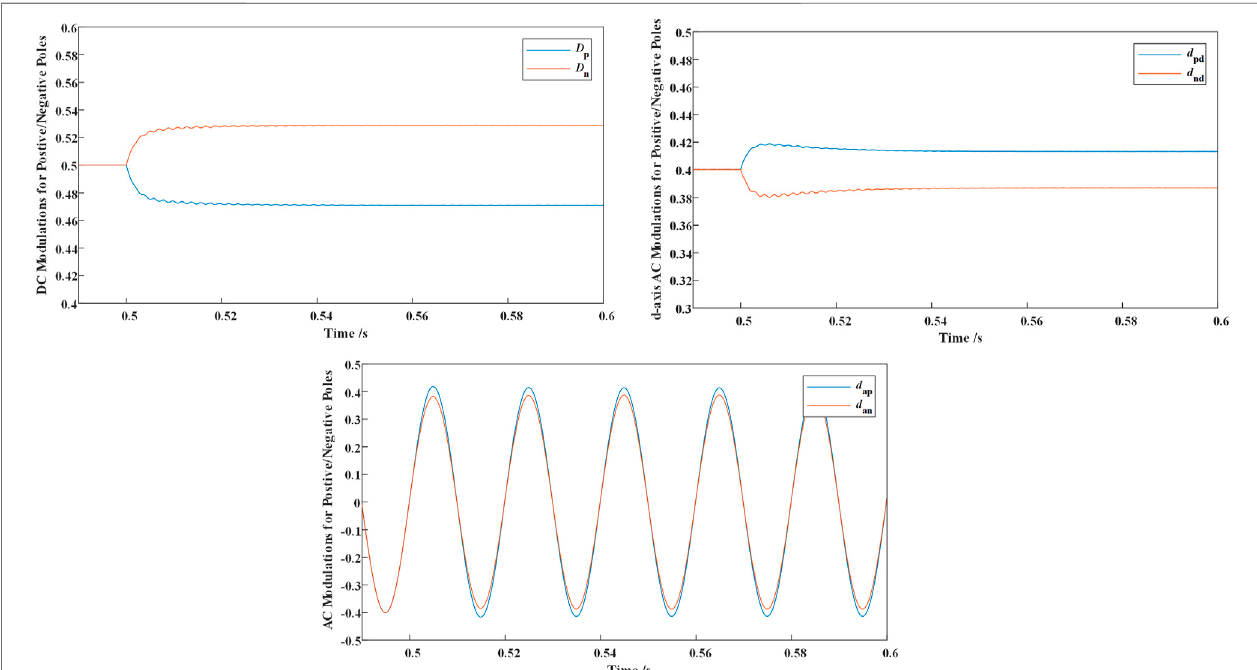
FIGURE11| Modulation variation during the event (DC modulations D p and D n ; d-axis AC modulations d pd and d nd ; and ACmodulations forphase A d ap and d an ).